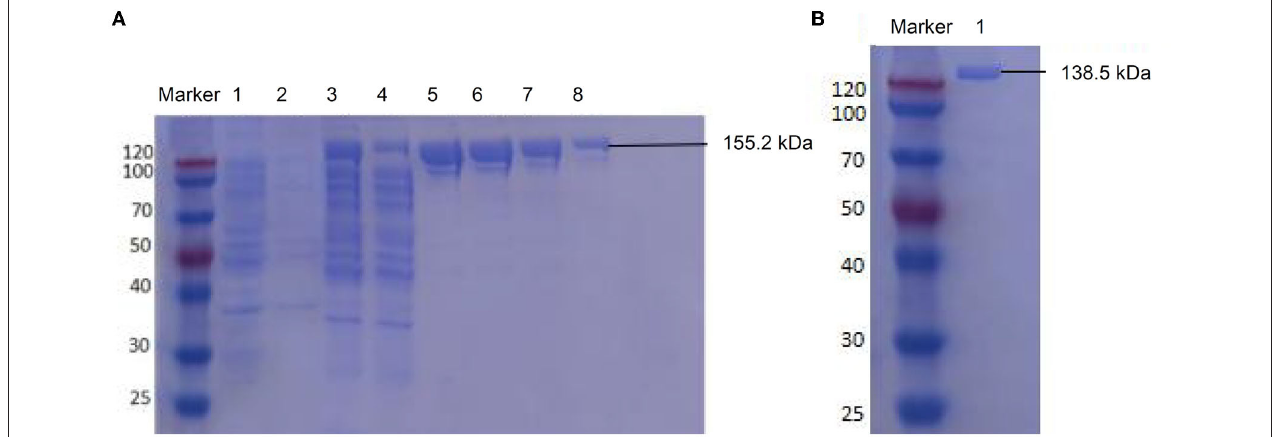
FIGURE 2 | SDS-PAGE electrophoresis for LwCas13a purification. (A) Undigested LwCas13a protein (155.2 kDa). lane M: protein marker, lane 1: uninduced bacterial sample, lane 2: precipitation of induced sample, lane 3: supernatant of the induced sample, lane 4: flow-through sample, lane 5–8: elution with 500mM imidazole. (B) Digested LwCas13a protein (138.5 kDa). lane marker: protein marker, lane 1: the purified LwCas13a protein.